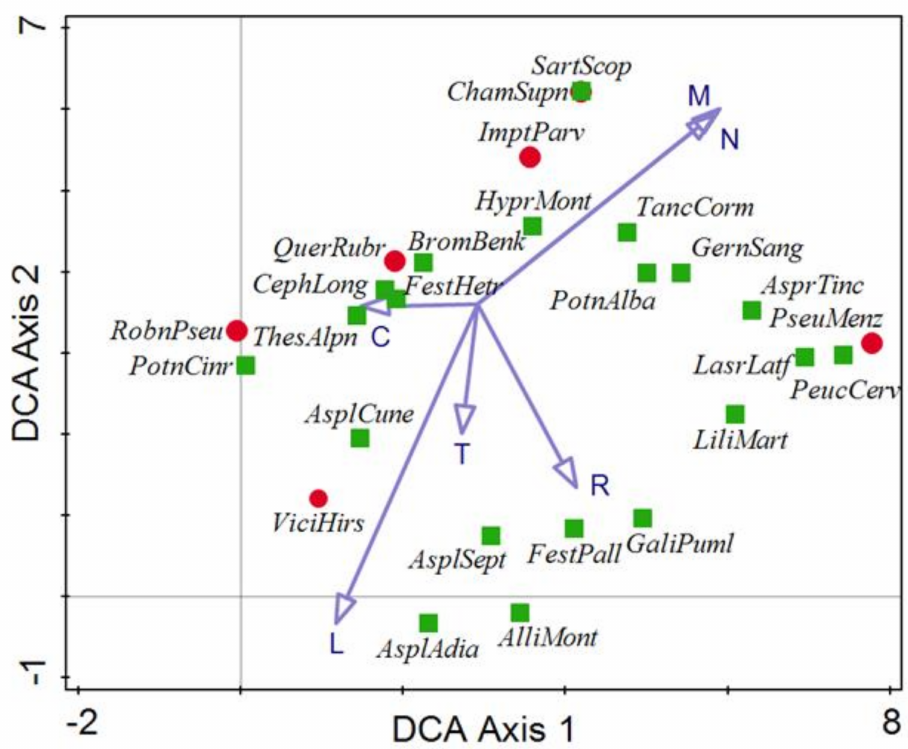
Figure 3. The passive projection of Ellenberg indicator values (EIVs) into DCA distribution diagram of alien (red circles) and rare/endangered species (green squares) recorded in serpentine forest communities in SW Poland. Species scores limit to 26 by weight. Abbreviations of species names are in accordance with these presented in Tables 2 and 3. Explanation: C—EIV for continentality; T—EIV for temperature; L—EIV for light; M—EIV for moisture; R—EIV for soil reaction; N—EIV for